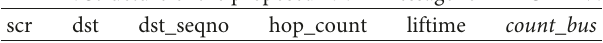
Table 2: Structure of the proposed RREP message for